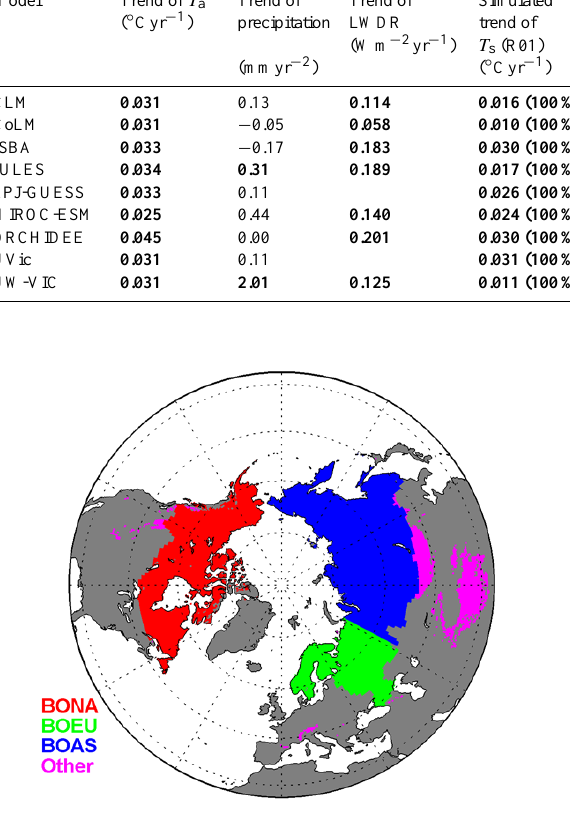
Figure 1. The spatial extent of regions defined in this study. Red, green, blue, and magenta indicate the regions of boreal North Amer- ica (BONA), boreal Europe (BOEU), boreal Asia (BOAS), and other permafrost areas (Other), respectively. We only selected the BONA, BOEU, and BOAS sub-regions for analysis in this